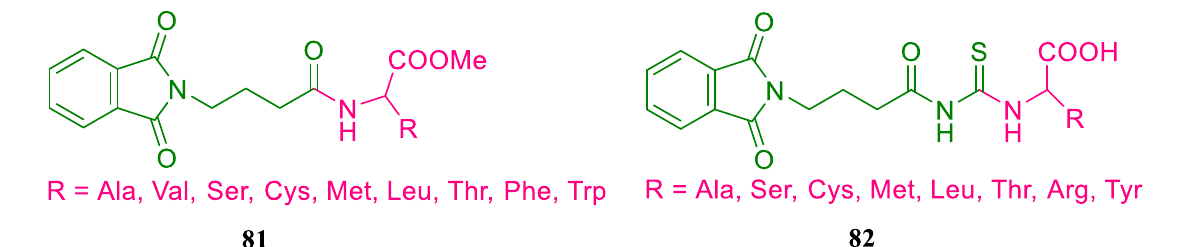
Figure 66. N - α -amino acids conjugated to phthalimide moieties.